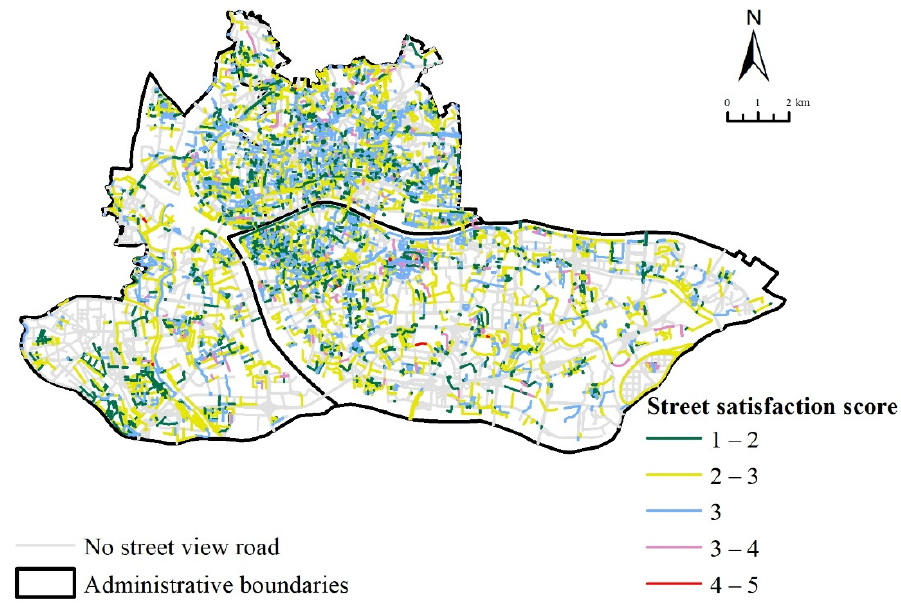
Figure 7. Satisfaction of the Quality of Street Space for Senior Citizens’ Physical Leisure Activity.